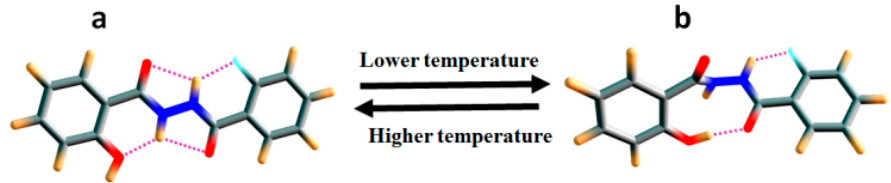
13 of 41 Figure 14. The chemical structures of 2-X- N -(2-X’) benzohydrazide derivatives; ( a ) symmetrically substituted molecules and ( b ) asymmetrically substituted molecules. For discarding any possibility of dimerization or self-aggregation, if any, 2D DOSY [137,138] experiments, ESI-MS analysis and dilution studies have been carried out. Solvent titration experiment [63,64,139] has been employed to understand the weak interactions, such as, intra- and inter- molecular HB, to compare their relative strengths of interaction and also to evaluate the effect of monomeric water on HB, which is absorbed from the atmosphere. The variation in the chemical shift of NH proton as a function of temperature (300–220 K) is compared for all the investigated molecules